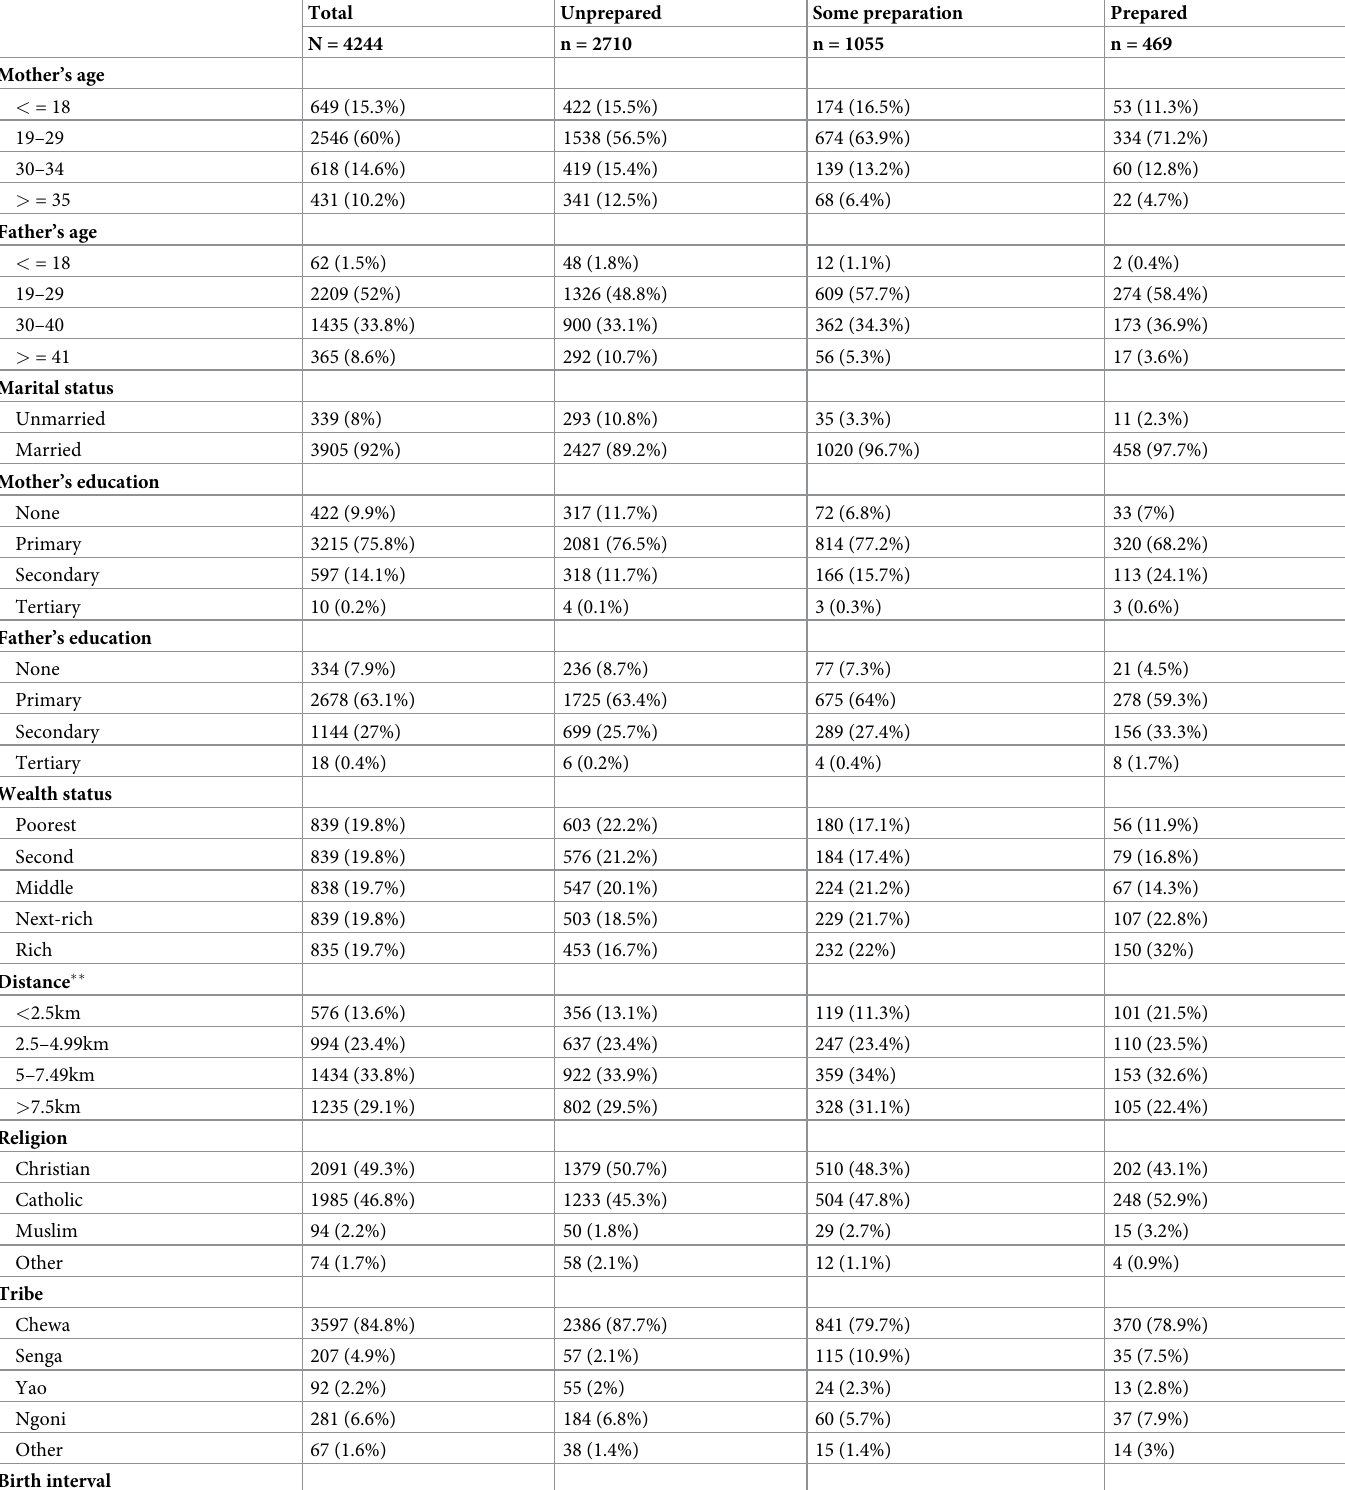
Table 2. Summary of socio-demographic and obstetric characteristics by level of pregnancy preparation by women in